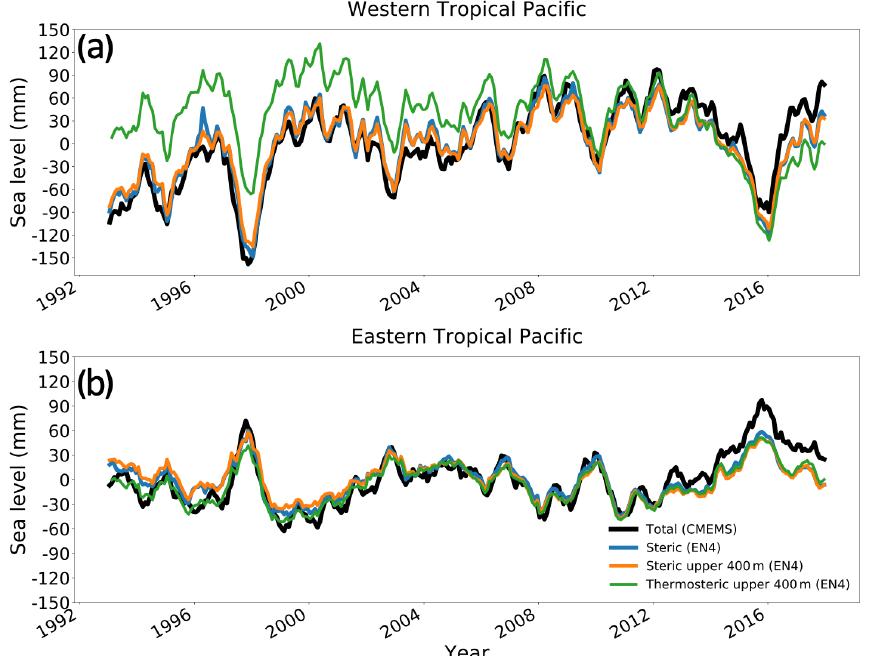
Figure 1. Time series of regional mean total sea level from CMEMS (black), steric sea level from EN4 (blue), upper 400m steric sea level from EN4 (orange), and upper 400m thermosteric sea level from EN4 (green) in the (a) western tropical Pacific (120 ◦ E–180 ◦ and 20 ◦ S–20 ◦ N) and (b) eastern tropical Pacific (180–60 ◦ W and 20 ◦ S–20 ◦